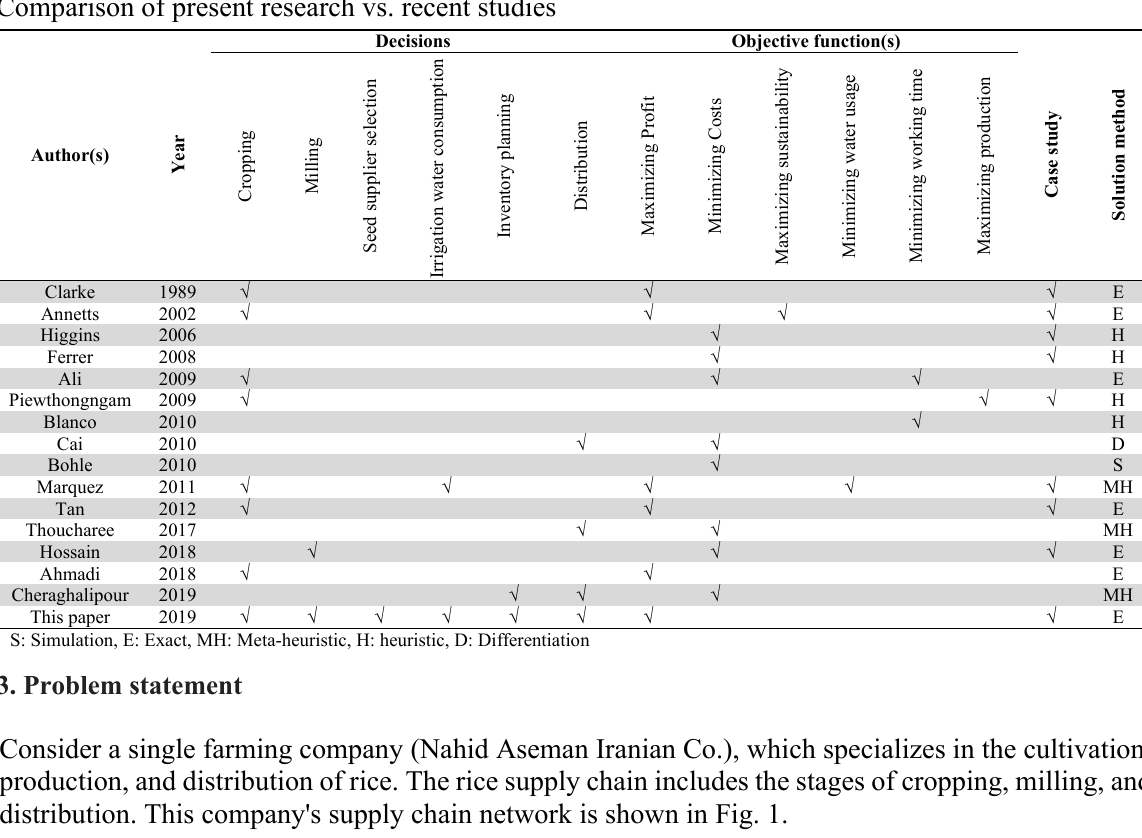
Comparison of present research vs. recent studies